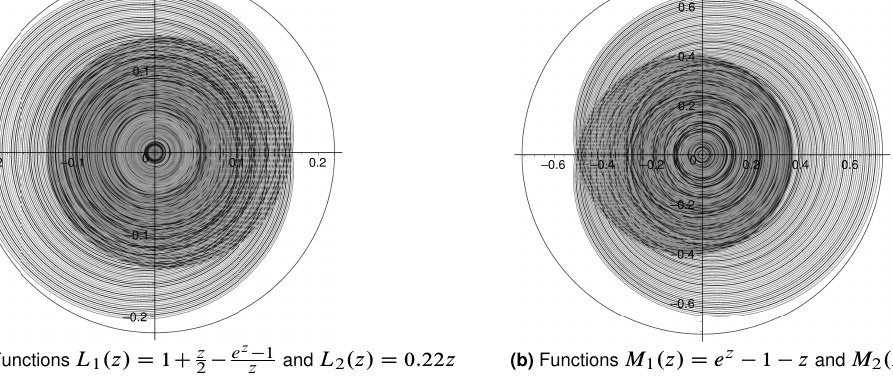
(a) Functions L 1 .z/ D 1 C z 2 (cid:0) e z (cid:0) 1 z and L 2 .z/ D 0:22z